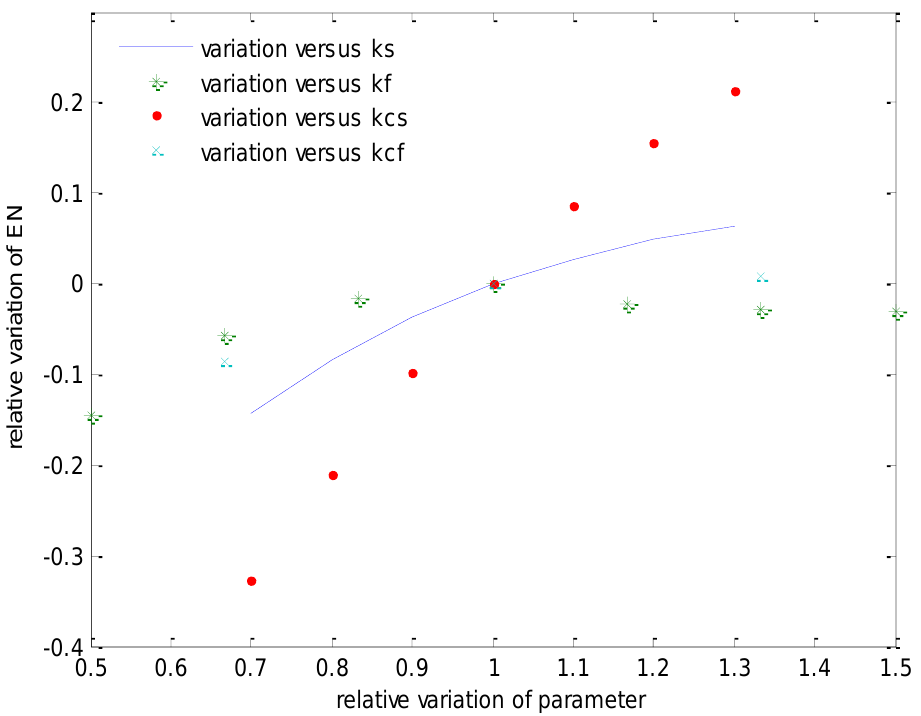
Fig. 4. The relative variation of E{ N }with respect to changes in the parameters TSCSTFCF, p U =0.9, p L =0.6, α=0.05,